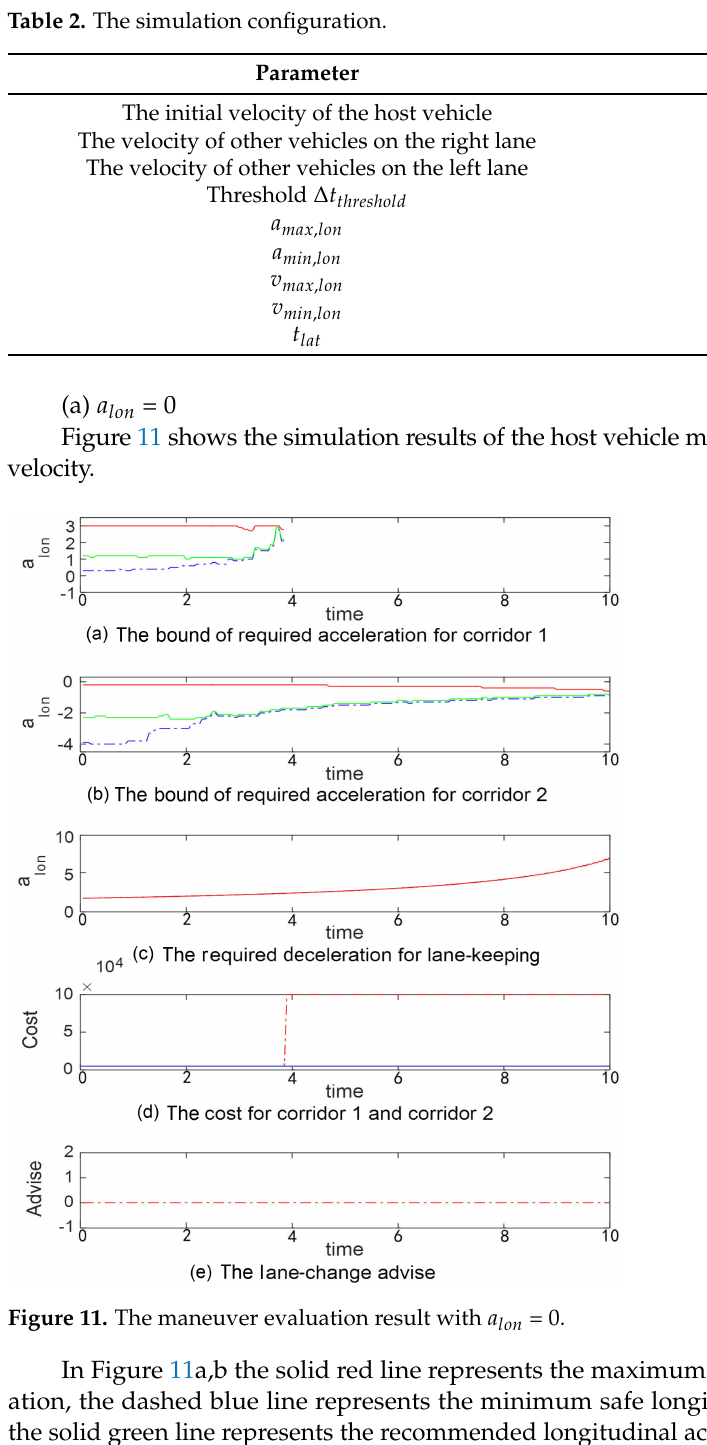
ation, the dashed blue line represents the minimum safe longitudinal acceleration, and cost. In Figure 11c, the solid blue line represents the required minimum longitudinal deceleration for lane keeping. In Figure 11d, the dashed red line represents the cost